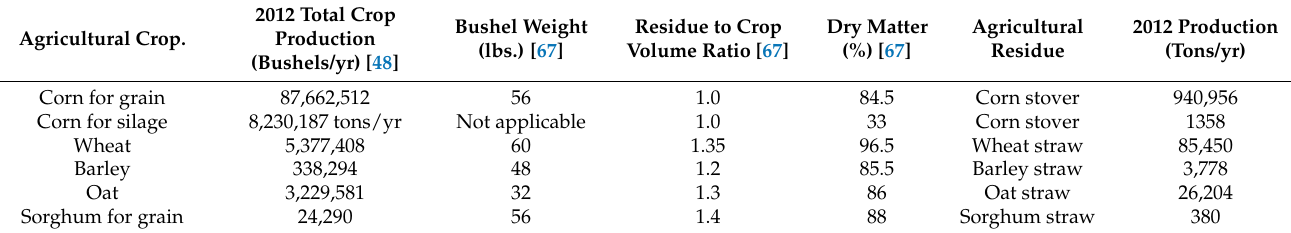
Table A1. Agricultural residues estimate for New York